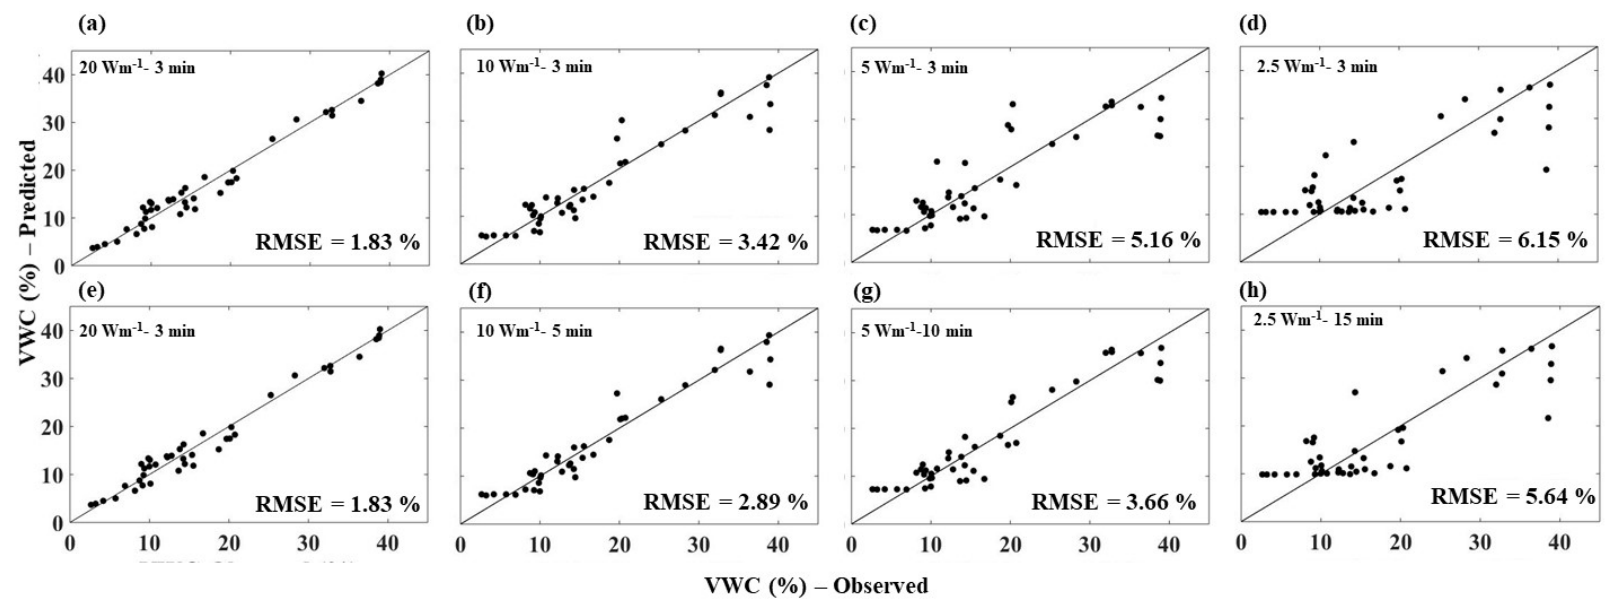
Figure 10. Comparison between AHFO predicted and observed (gravimetric method) soil water content of clay loam soil for all the heating strategies. Note: ( a ) and ( e ) are similar (20 Wm − 1 –3 min) and are used to compare with the short pulses (along row 1) and with the long pulses (along row 2).